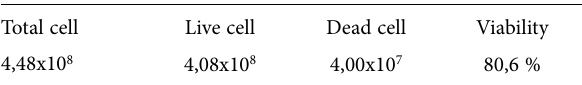
Table 1. Desmodesmus sp. cell counting and cell viability analysis